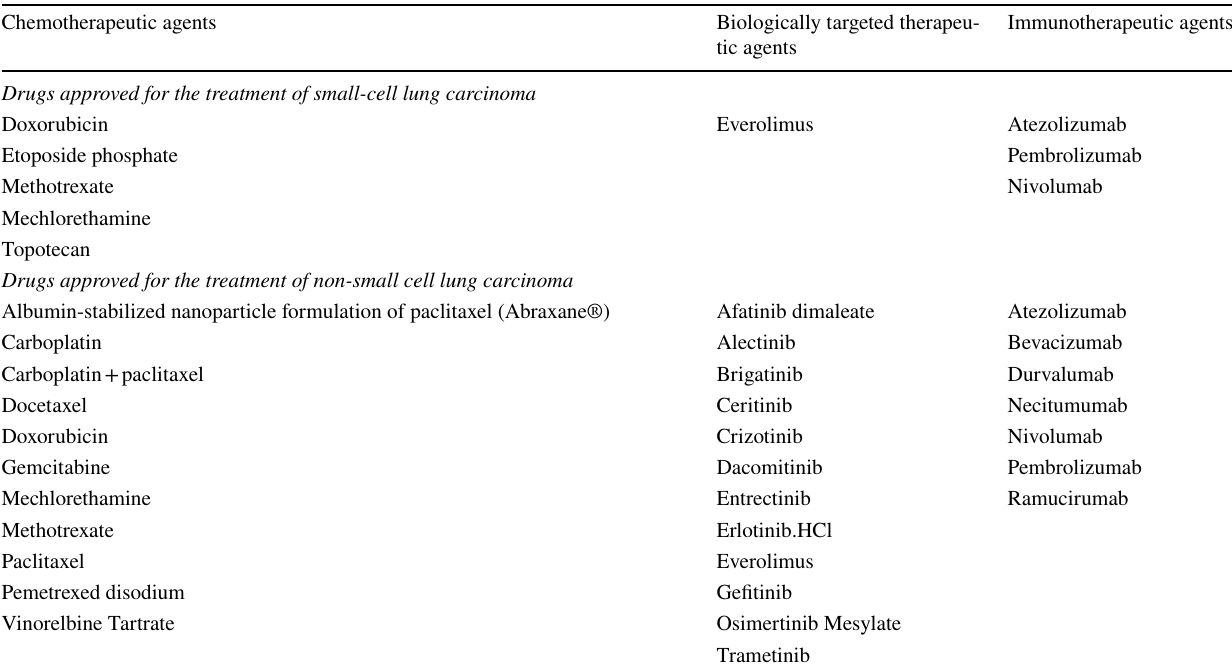
Table 2 Drugs approved for the treatment of lung cancer Chemotherapeutic agents Biologically targeted therapeu- Drugs approved for the treatment of small-cell lung carcinoma